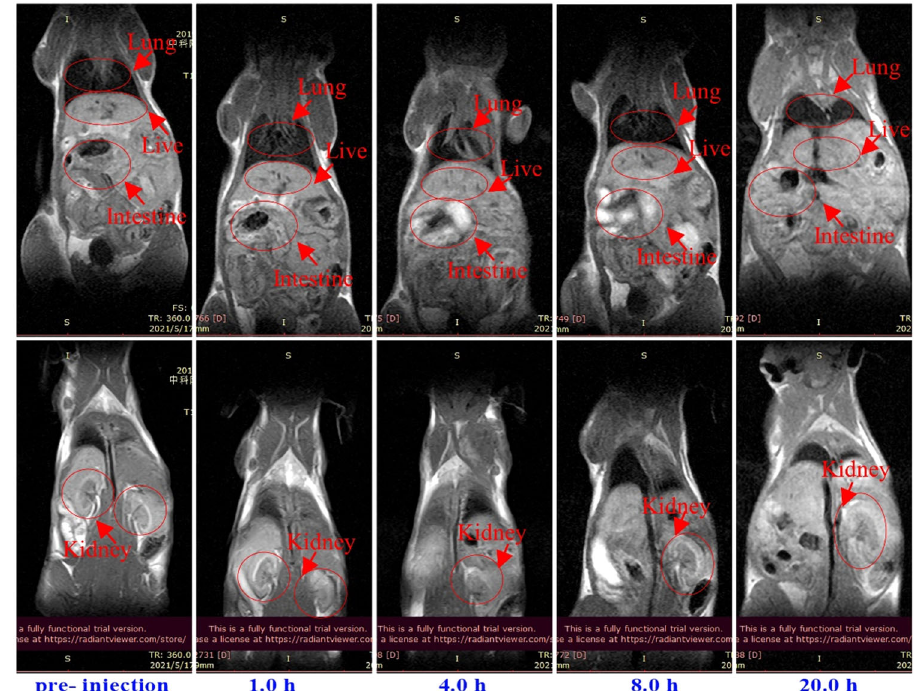
Fig. 6 In vivo T1-weighted MRI images of mice with intravenous injection of the BCQD@Mn composite at different time